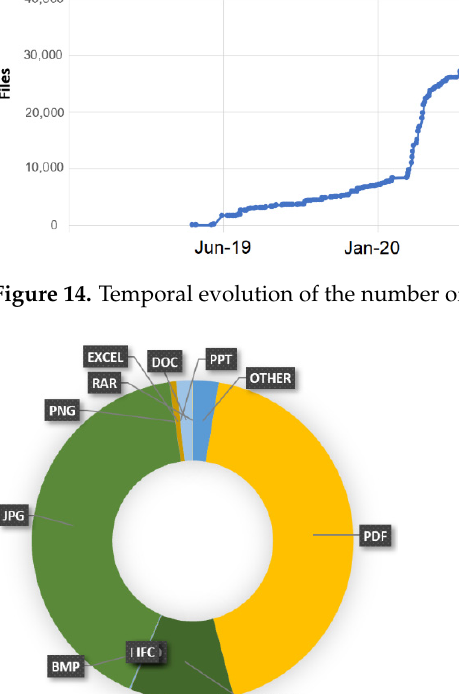
Figure 15. File types stored in the common data environment.